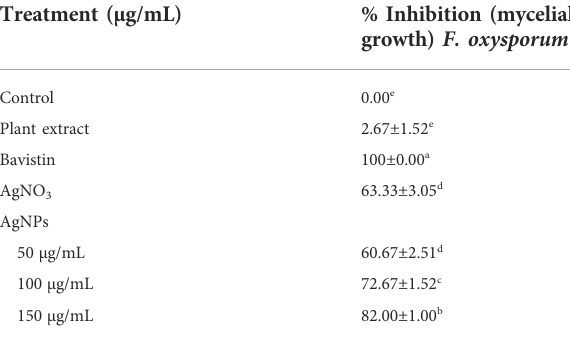
TABLE 1 Mycelial growth inhibition activity of synthesized AgNPs against F. oxysporum . Treatment